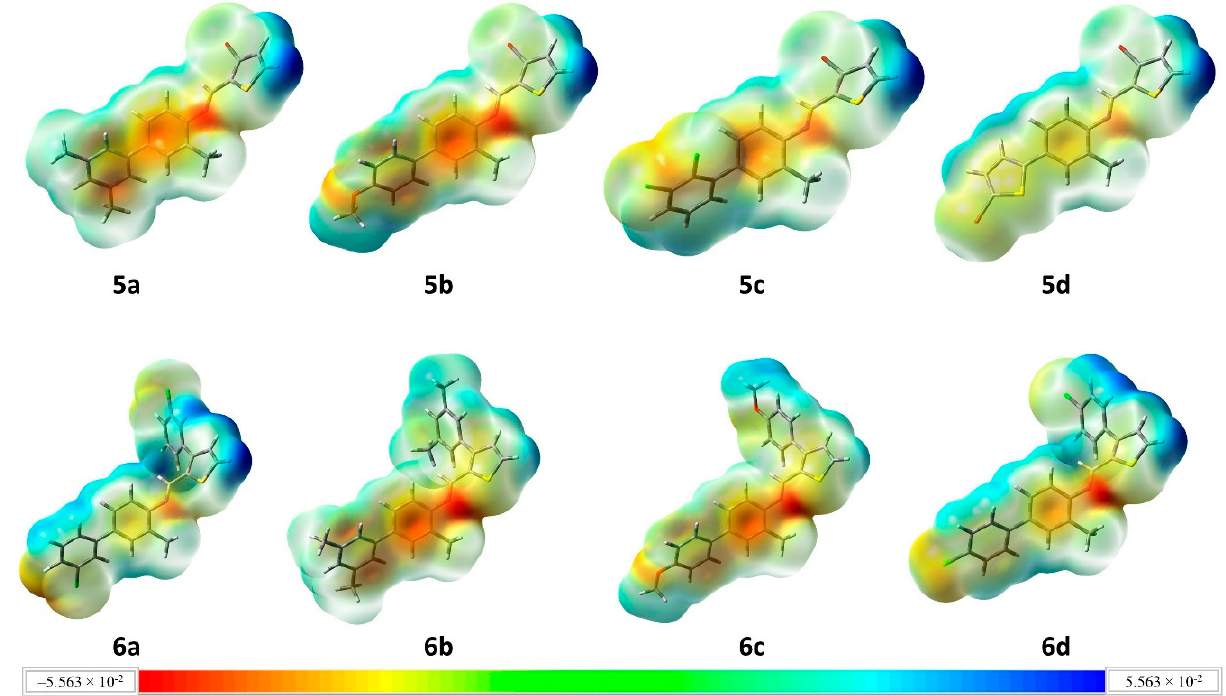
Figure 4. A presentation of all the molecular electrostatic potentials of all the molecules ( 5a – 5d , 6a – 6d ) calculated at PBE0-D3BJ/def2-TZVP/SMD 1,4-Dioxane level of theory. The scale below shows the colour coding. The values in the scale are in Hartrees. Table 2. Reactivity descriptors ( I , A , η , µ , ω ) of the synthesized analogues compounds under study.